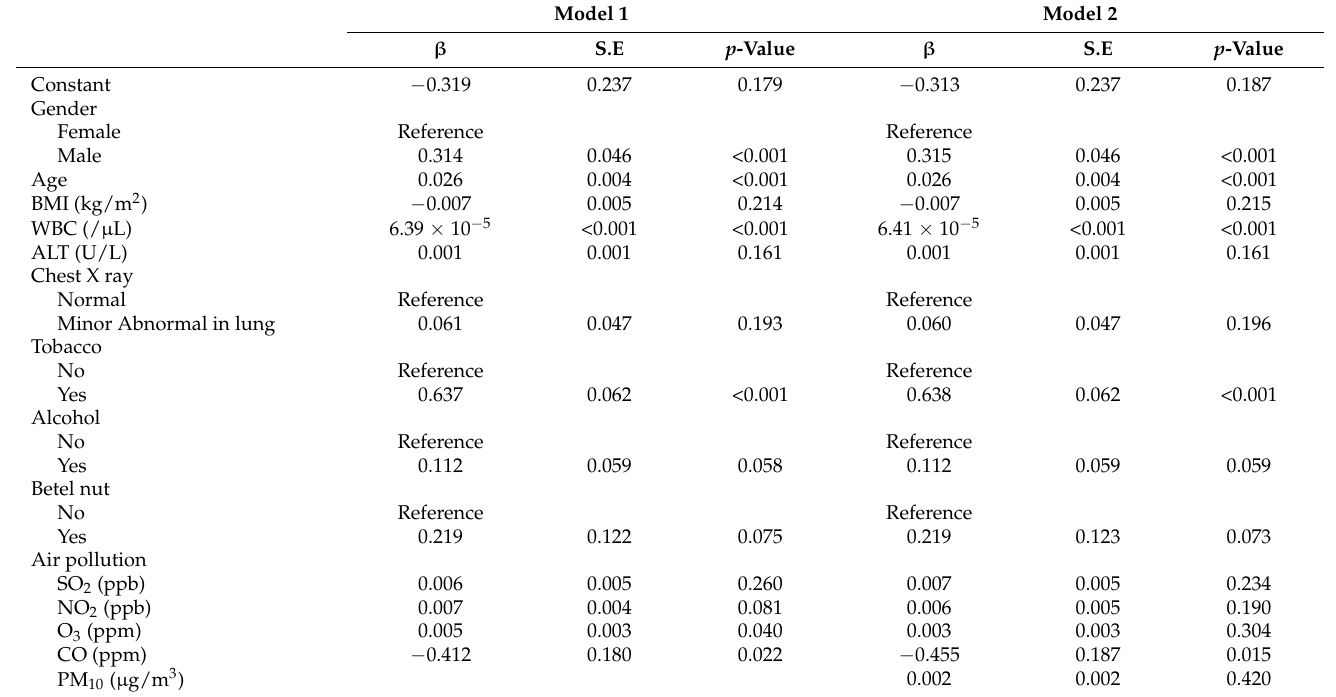
Table 5. Multiple linear regression across carcinoembryonic antigen (CEA) according to gender, age, BMI, WBC, ALT, chest X-ray, tobacco, alcohol, betel nut, air